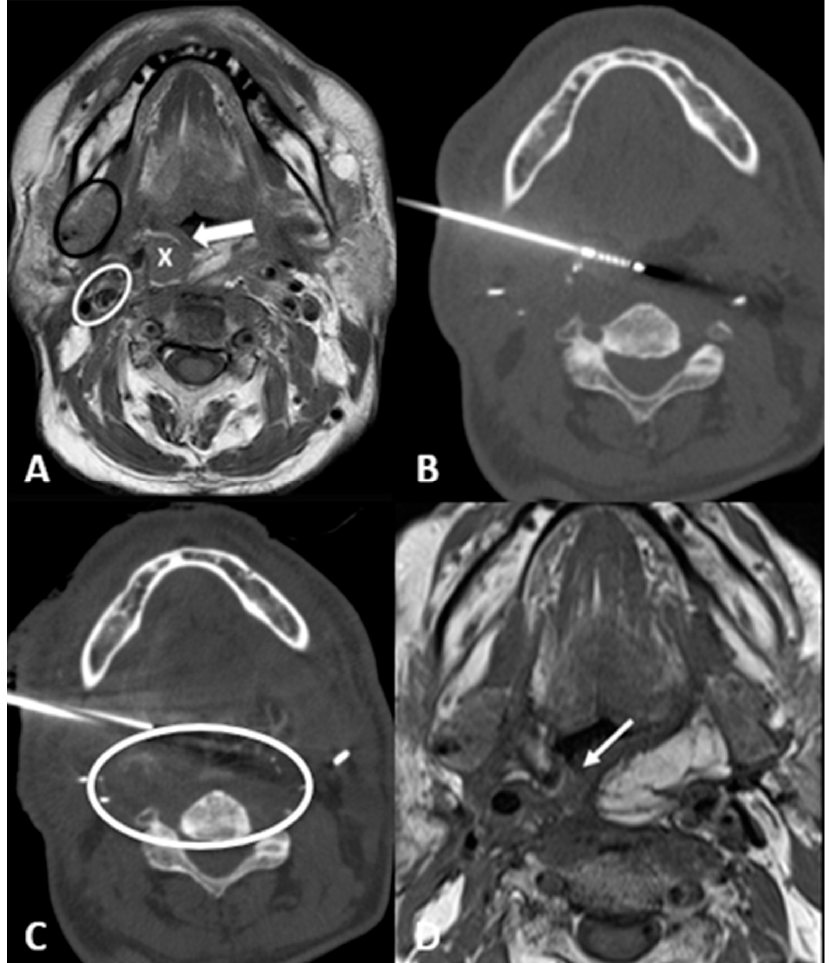
Figure 3. 63-year-old male with recurrence of supraglottic squamocellular carcinoma which underwent previous total pharyngolaryngectomy and bilateral neck dissection. ( A ) T1-weighted unenhanced axial MRI scan showing the tumor recurrence (X), the mucosa of the neopharynx (arrow), the right submandibular gland (black circle), and the right carotid space (white circle). ( B ) Axial CT scan showing the cryoprobe positioned in the lesion through a trans-submandibular gland ap- proach. ( C ) Axial CT scan showing parallel needle placement for hydrodissection of peritumoral tissue. ( D ) One-month T1-weighted unenhanced axial MRI scan showing the postablation tumor shrinkage